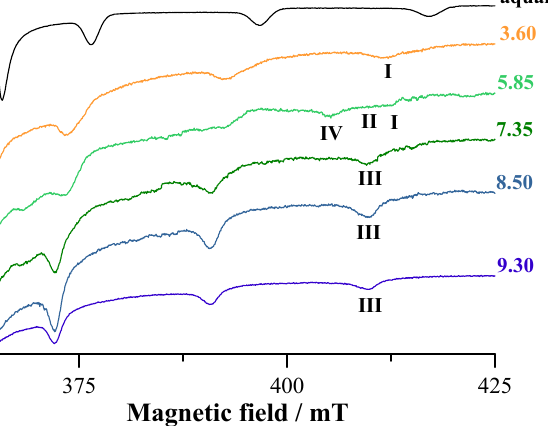
Figure 6. High-field region of the anisotropic X-band EPR spectra recorded on frozen solutions (120 K) of V IV O 2+ -L4 at 1:2 molar ratio and V IV O 2+ concentration 2 mM at different pH.